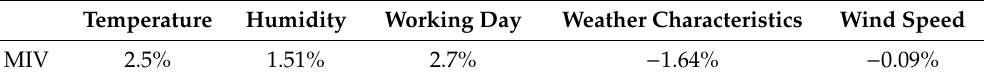
Table 3. Mean impact value (MIV) rates (%) for the input factors